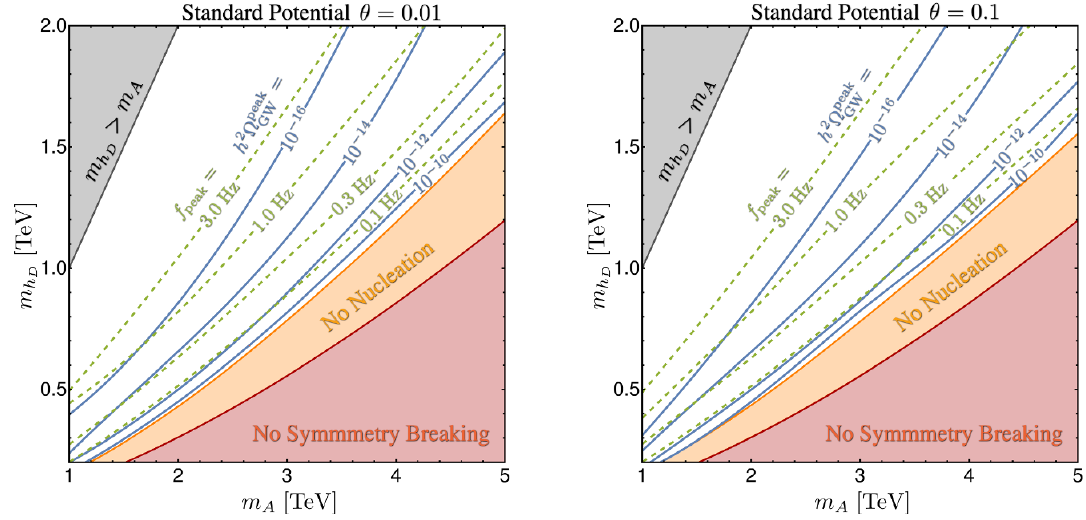
Figure 5 . Similar to (cid:12)gure 4, but with contours of the peak frequency and the corresponding GW energy density assuming v w = 1.